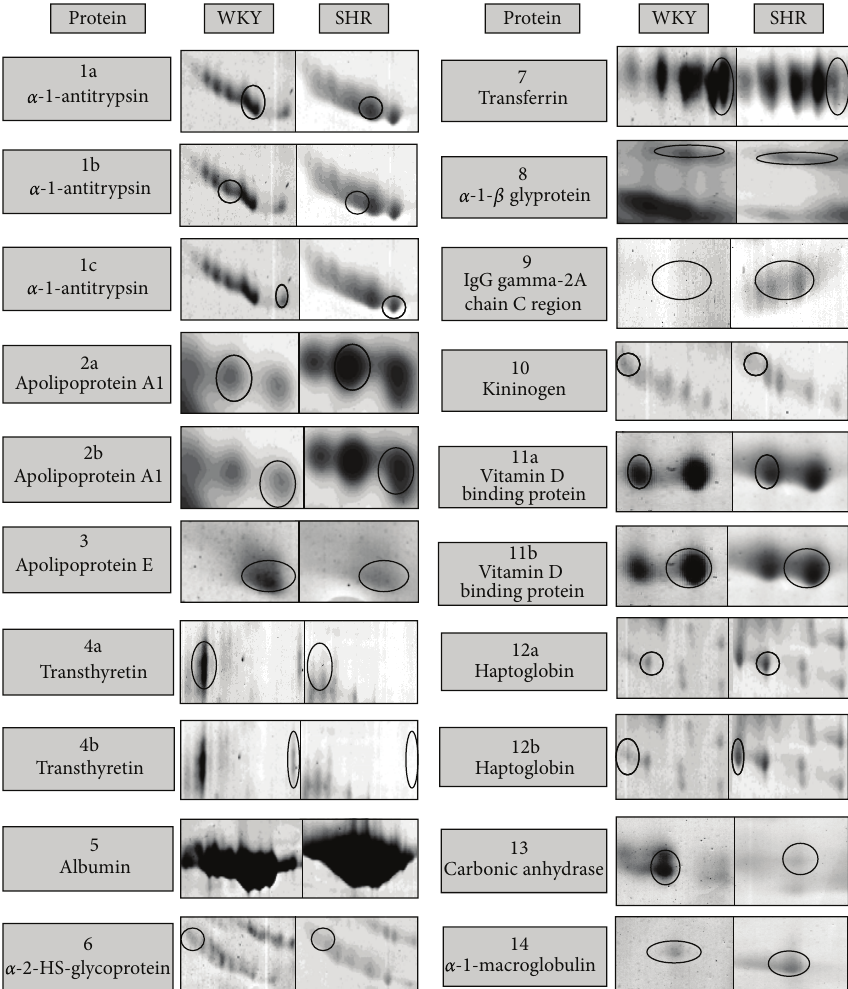
F 4: Zoom in two-dimensional gel of differential